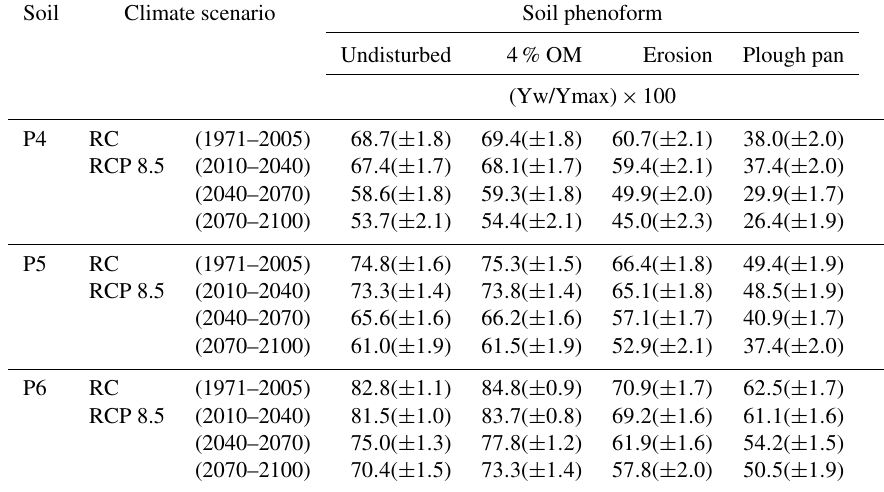
Table 4. SQw index, (Yw/Ymax) × 100, for the three selected soils and the four climate periods. Ymax is assumed to be 20tonsha − 1 . Soil Climate